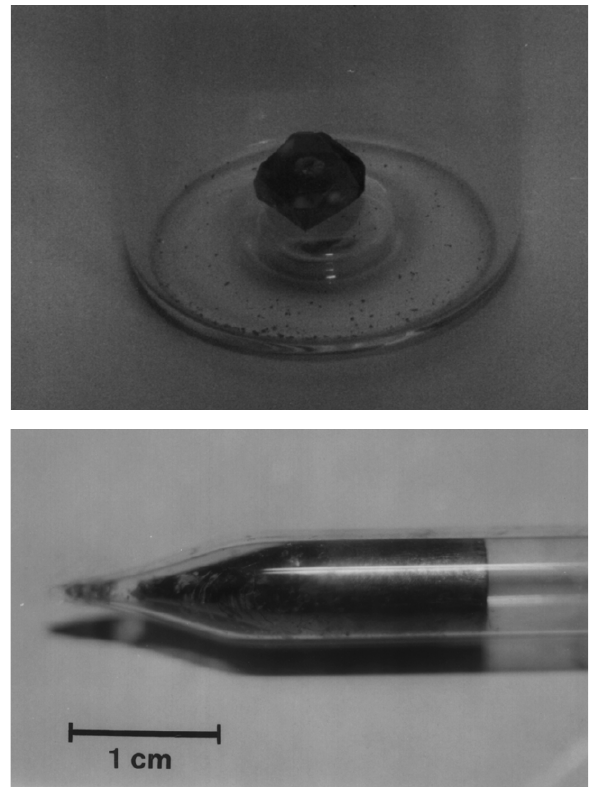
Figure 2. (A) Mercuric iodide single crystal grown by PVT method. (B) PbI 2 crystal grown by Bridgman technique.